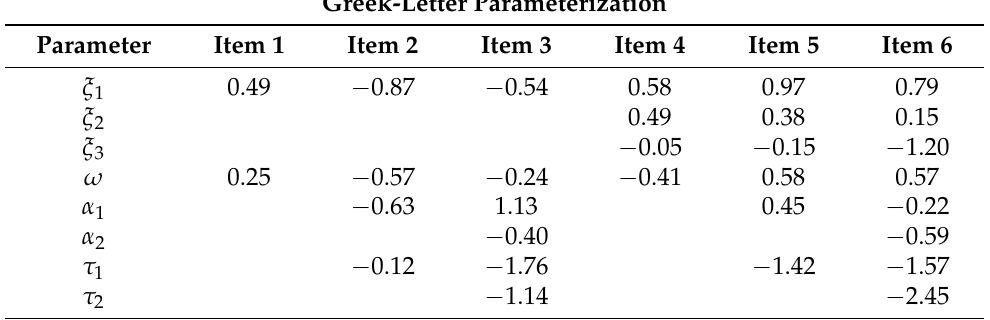
Table 1. Example FMP item